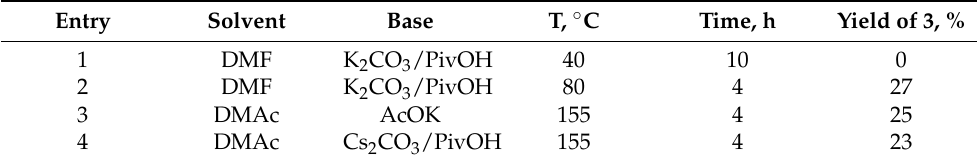
Table 1. Reaction of 4,7-dibromobenzo[ c ][1,2,5]thiadiazole 1 with 4,4-bis(2-ethylhexyl)-4 H